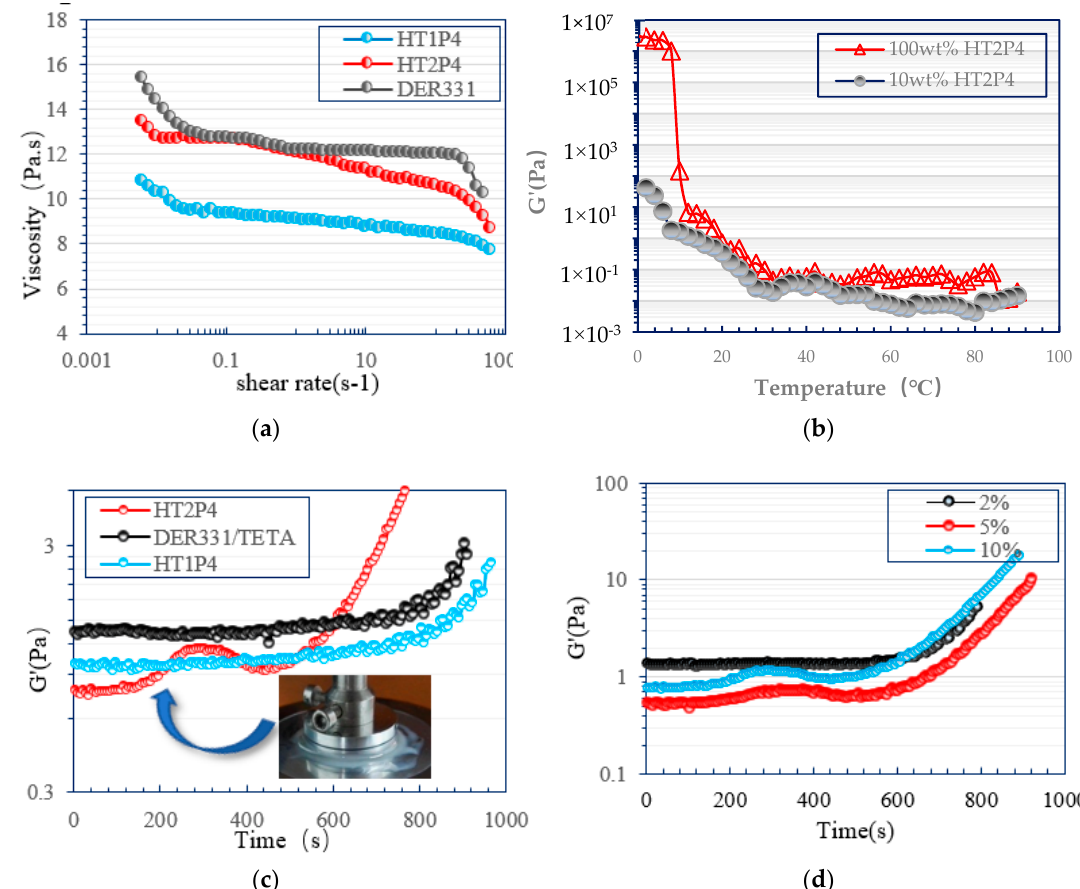
Figure 3. ( a ) Steady shear viscosity profiles of neat DER331, DER331/HT1P4 (10 wt %) and DER331/HT2P4 （ 10 wt % ） as a function of shear rate at 25 °C; ( b ) Dynamic viscoelastic moduli vs. temperature by oscillatory shear for neat HT2P4, DER331/HT2P4 (10 wt %) blend at sweep cooling rate of 5 °C/min (strain = 3.125%, angular frequency = 1 rad/s, 25 mm parallel plate); ( c ) Dynamic viscoelastic moduli vs. time by oscillatory shear for neat DER331/TETA blend, DER331/TETA/HT1P4(10 wt %) blend, and DER331/TETA/HT2P4(10 wt %) blend at 60 °C (strain = 3.125%, angular frequency = 1 rad/s, 25 mm parallel plate); ( d ) Dynamic viscoelastic moduli vs. time by oscillatory shear for DER331/TETA/HT2P4 blends at different mass ratio of HT2P4 at 60 °C (strain = 3.125%, angular frequency = 1 rad/s, 25 mm parallel plate).